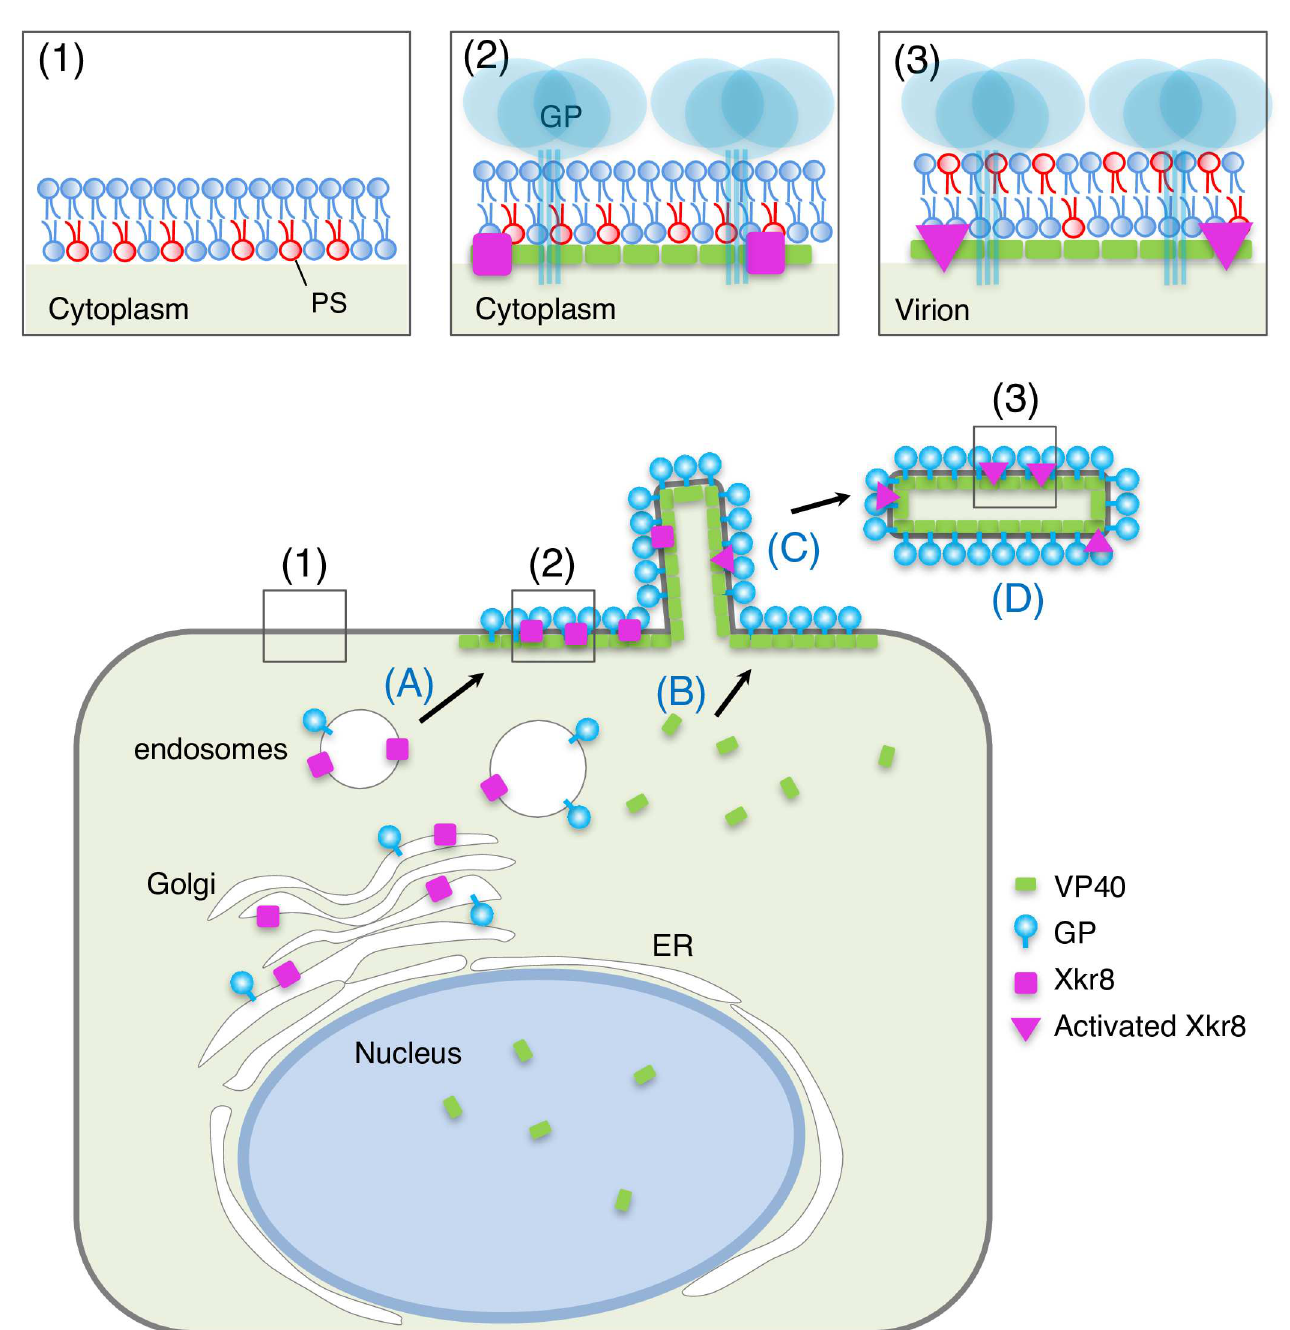
Fig 7. Role of Xkr8 in PS exposure on the surface of virus particles. Xkr8 is transported to the budding sites together with GP via intracellular vesicles (A). VP40 is independently transported to the PM (B). Transported GP and Xkr8 are incorporated into virus particles (C). Incorporated Xkr8 is activated by a caspase (D), which leads to externalization of PS in the envelope of the EBOV particles (1–3).